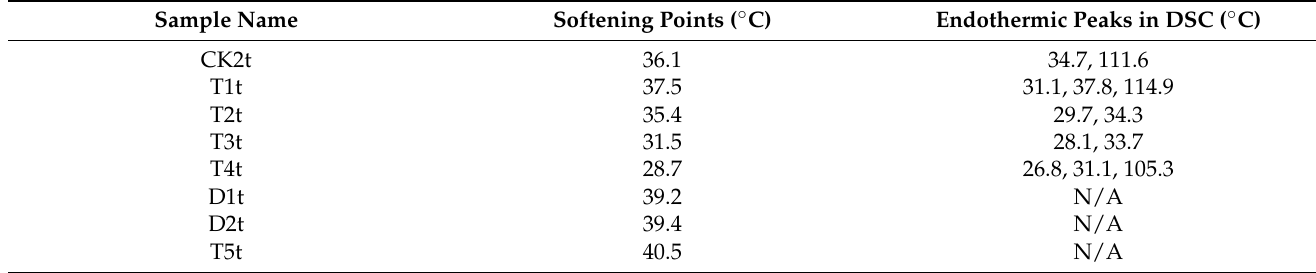
Table 1. Softening points and DSC endothermic peaks of oil-phase